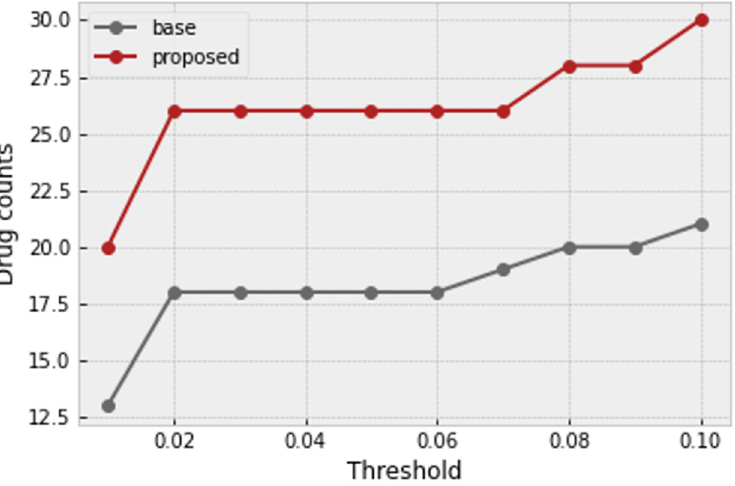
Fig 18. Comparison of drug counts for each P-value threshold. Drug counts for each P-value threshold are compared between base profiles and our proposed method (Thresholds in the plot are divided by the total number of drugs for using Bonferroni correction method in actual